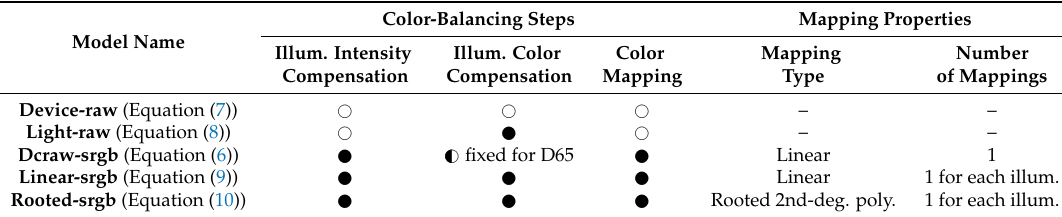
Table 1. Main characteristics of the tested color-balancing models. Regarding the color-balancing steps, the open circle denotes that the current step is not implemented in the given model, while the filled circle denotes its presence. Regarding the mapping properties, the dash denotes that the given model does not have this